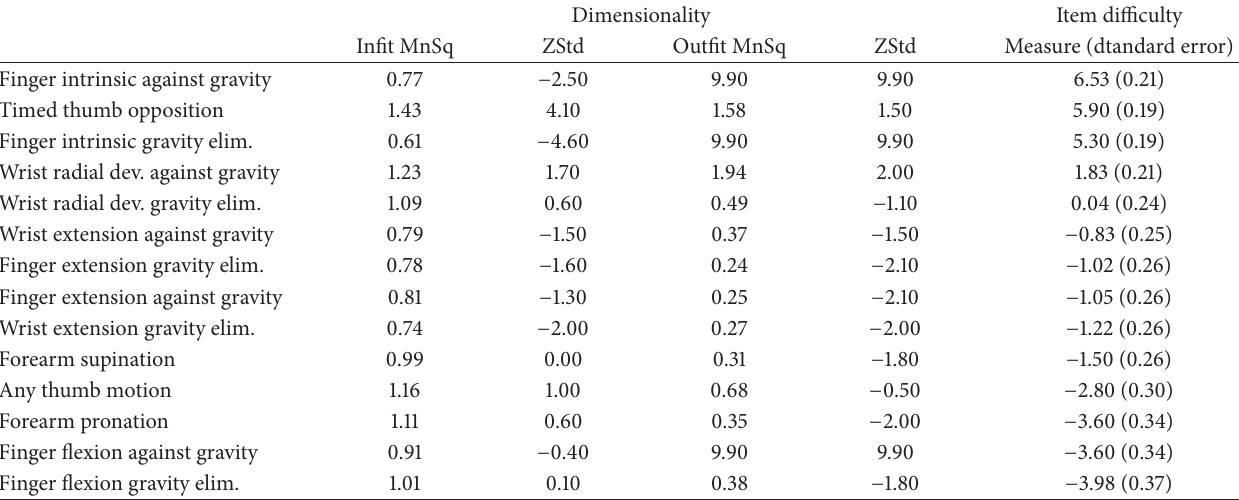
Table 1: Behavioral criteria statistics for hand movements item.